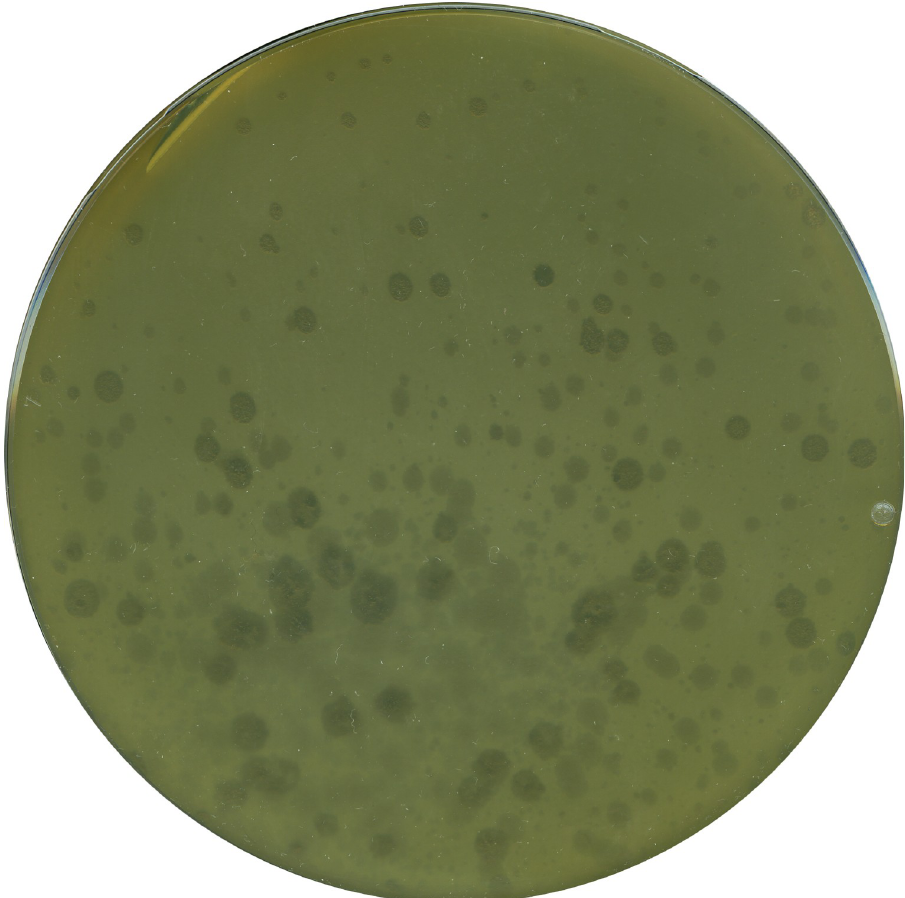
Fig 5. Host strain LVF3 challenged with metaviral sample. Different plaque morphologies can be observed. S1 Fig. Phylogenetic classification of Serratia marcescens strain LVF3. (PDF) S2 Fig. Visualization of functional categories through BlastKoala (Kanehisa et al., 2016) [38] for Serratia marcescens LVF3 R . Functional categories of (A) chromosome and (B) plas- mid can be seen by the presented color code. (PDF) S3 Fig. Colony morphotype of Serratia marcescens LVF3 R . Growth experiments were per- formed using TSA-10 agar plates. S4 Fig. Gram staining of Serratia marcescens LVF3 R . (PDF) S5 Fig. Analysis of antibiotic resistances through soft-agar assay with discs (A) and strips (B). Exemplarily, antibiotic resistance of isolate LVF3R is indicated by halo formation. Incubation took place overnight at 30˚C. (A) Meropenem (0.002–32 μ g), and (B) kanamycin (30 μ g),